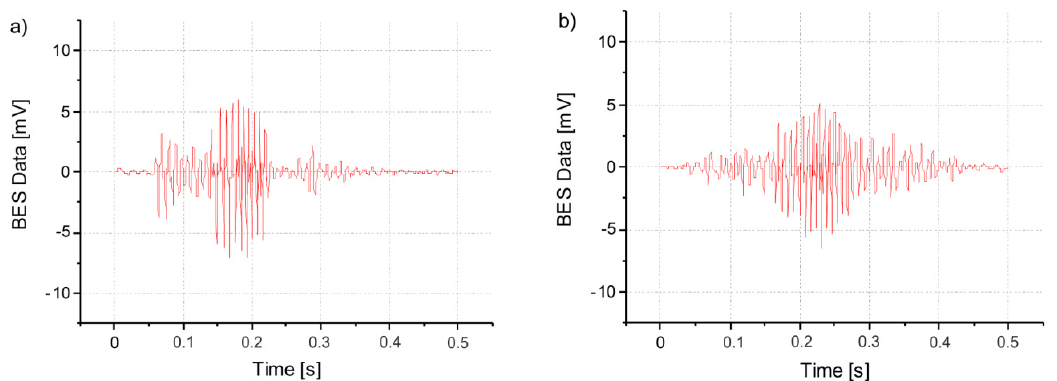
Figure 6. Recorded time-dependent BESs spectrum activated by muscle tension inside the head: ( a ) pressing the tongue, ( b ) clenching of jaws.